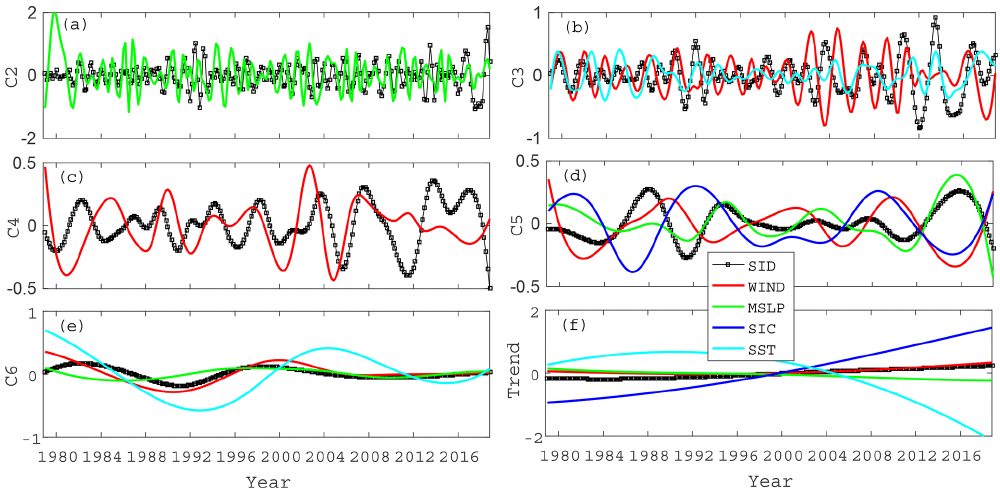
Figure 8. The IMF modes (a–e) and trend components (f) after EEMD of the first sea ice EOF temporal coefficient and each environmental parameter. (For each environmental parameter, only the EOF component marked with an asterisk is drawn.)